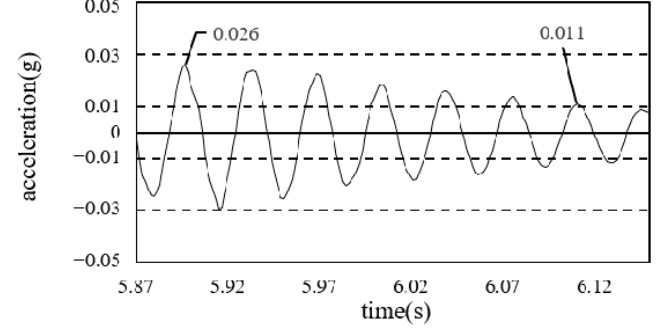
Figure 8. Damping ratio (framing completion).